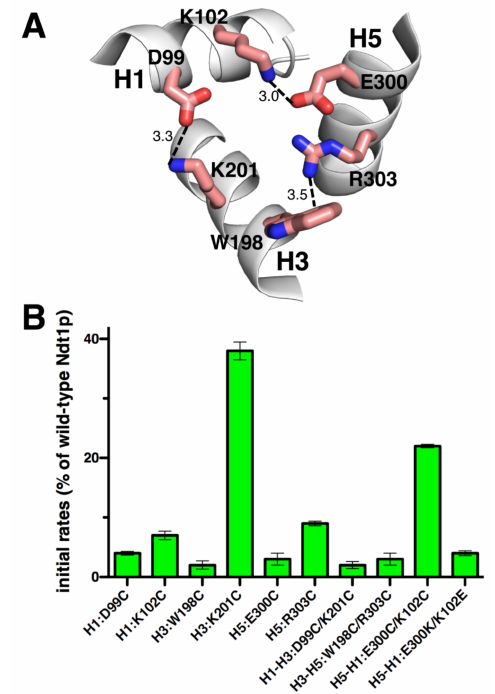
Figure 4. Initial transport rates of the Ndt1p cysteine mutants. ( A ) The PX[DE]XX[KR] motifs in the C-state Ndt1p homology model with the salt bridges and the hypothetical cation- π interaction indicated by lines and distances in Å. ( B ) Initial transport rates of Ndt1p cysteine mutant proteins reconstituted in liposomes. Transport was started by adding 3 mM of 14 C-NAD + to proteoliposomes containing 20 mM NAD + and stopped after 30 sec by the stop inhibitor method. The activity is expressed as the percentage initial rate of wild-type Ndt1p, which was 1067( ± 123) µ mol/min/g protein. The means ± S.D. of at least three independent experiments carried out in duplicate are